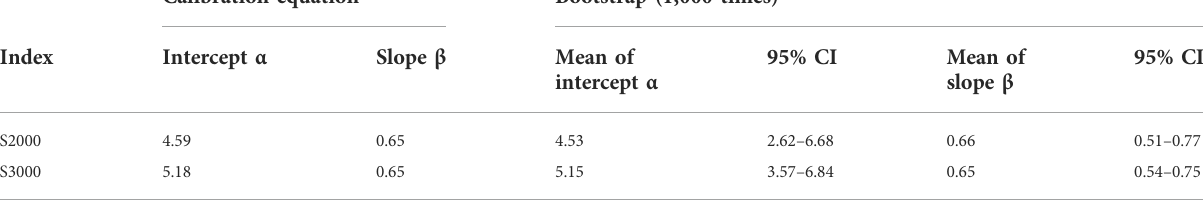
TABLE 2 Bootstrap internal validation of calibration equation results ( n = 35).